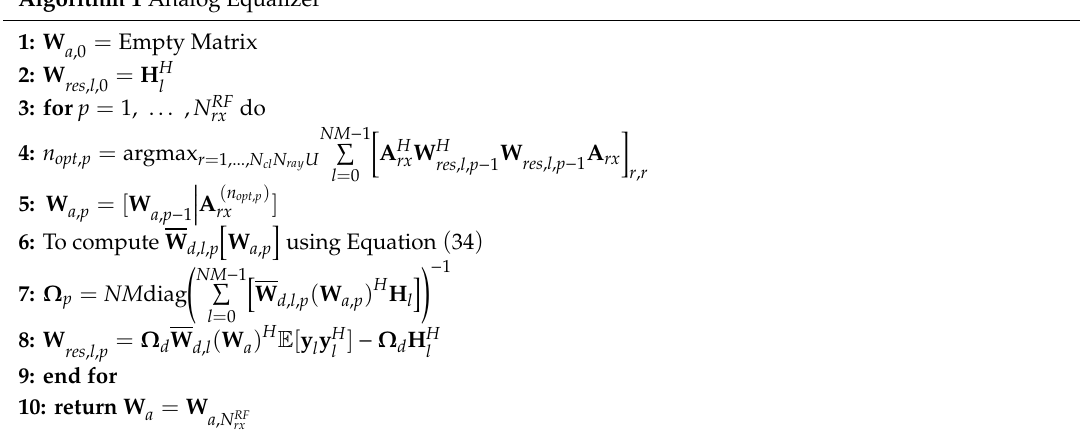
Algorithm 1 Analog Equalizer